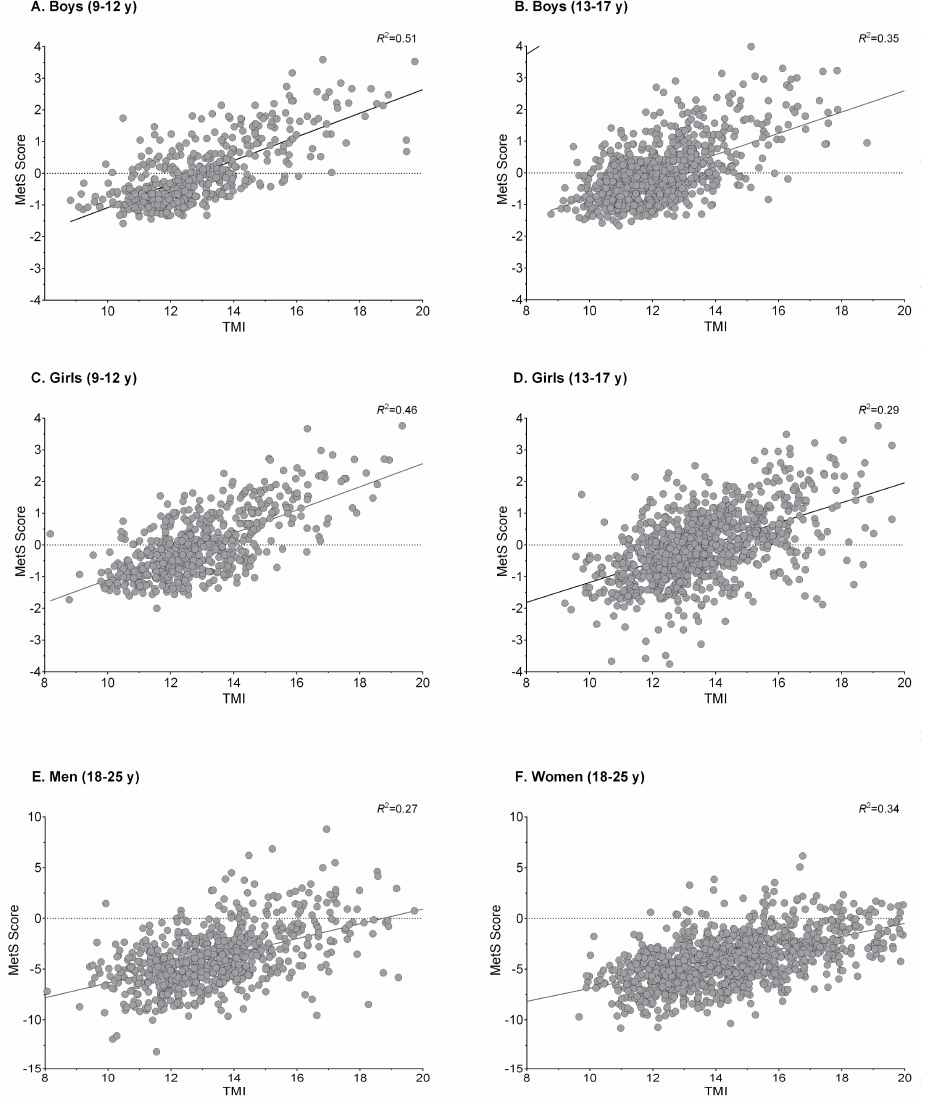
Figure 2. Association between TMI and MetS score for sex and age groups. MetS: metabolic syndrome; TMI: tri-ponderal mass